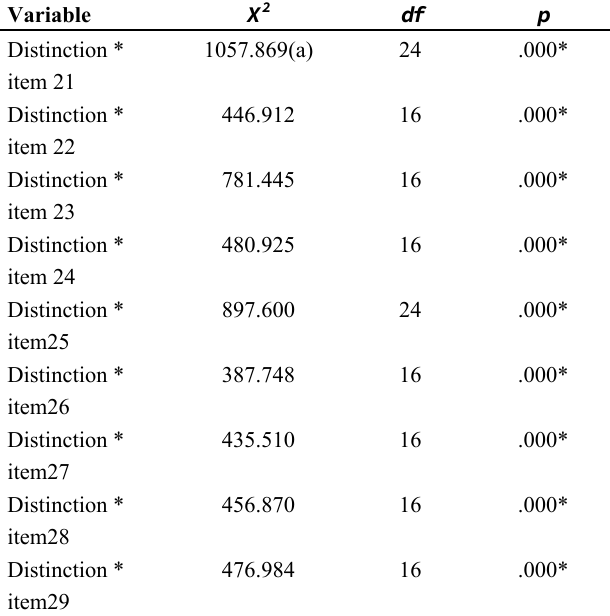
Table 8: The influence of integration on the